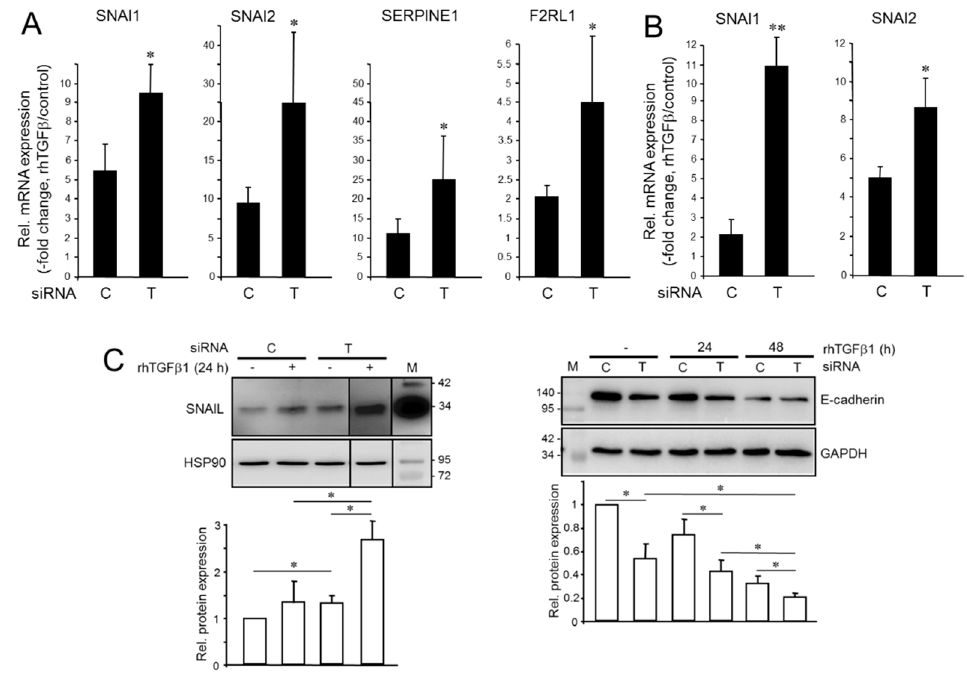
Figure 1. Effect of endogenous and recombinant human transforming growth factor β 1 (rhTGF β 1) on gene expression in tumor cells with aTGF β production. ( A ) Panc1 TGFB1-KD cells were transiently transfected twice on 2 consecutive days with 50 nM each of siRNA directed against TGFB1 (T) or a scrambled control (C) siRNA and incubated for another 48 h. Cells were then treated with rhTGF β 1 for 24 h and analyzed by qPCR for expression of the indicated genes and TATA box-binding protein (TBP) as a reference gene. Data are displayed as fold induction by rhTGF β 1 treatment over non- treated controls (means ± SD; n = 3 (SNAI1, SERPINE1), n = 4 (SNAI2, F2RL1)). ( B ) As in ( A ) except that MDA-MB-231 TGFB1-KD were analyzed. ( C ) Western blot analysis of SNAIL (left-hand blot) and E- cadherin (right-hand blot) in Panc1 TGFB1-KD cells treated, or not, with rhTGF β 1. Detection of heat shock protein 90 (HSP90) or glyceraldehyde 3-phosphate dehydrogenase (GAPDH) served as a loading control. The graphs below the blots show data quantification from densitometric readings of band intensities (mean ± SD, n = 3). The asterisks denote significance. The vertical lines between lanes 3, 4, and 5 of the left blot indicate that irrelevant lanes have been removed. Successful knock- down of TGFB1 was verified by ELISA of secreted TGF β 1 in culture supernatants (Figure S2). M, molecular weight marker. Numbers to the right or left of the blots denote band sizes in kDa. *, p < 0.05; **, p < 0.01. 2.2. Knockdown of TGFB1 Enhances the Migratory Response to rhTGF β 1 Having shown that endogenous and rhTGF β 1 display antagonistic effects on several invasion-associated genes, we asked whether depleting cells of endogenous TGFB1 ex- pression would alter their sensitivity to rhTGF β 1-induced cell migration. Of note, under both basal conditions and in response to challenge with rhTGF β 1 MDA-MB-231 TGFB1-KD or Panc1 TGFB1-KD cells exhibited a dramatic increase in chemokinetic activity, which was par- ticularly strong in Panc1 cells (Figure 2). Together, these data show that endogenous and exogenous rhTGF β 1 also exert antagonistic effects on cell migration and confirm the pre- vious assumption that aTGF β 1 signaling may protect tumor cells from mesenchymal con- version and an associated increase in cell motility by non-autocrine, stromal cell-derived TGF β 1 [16].